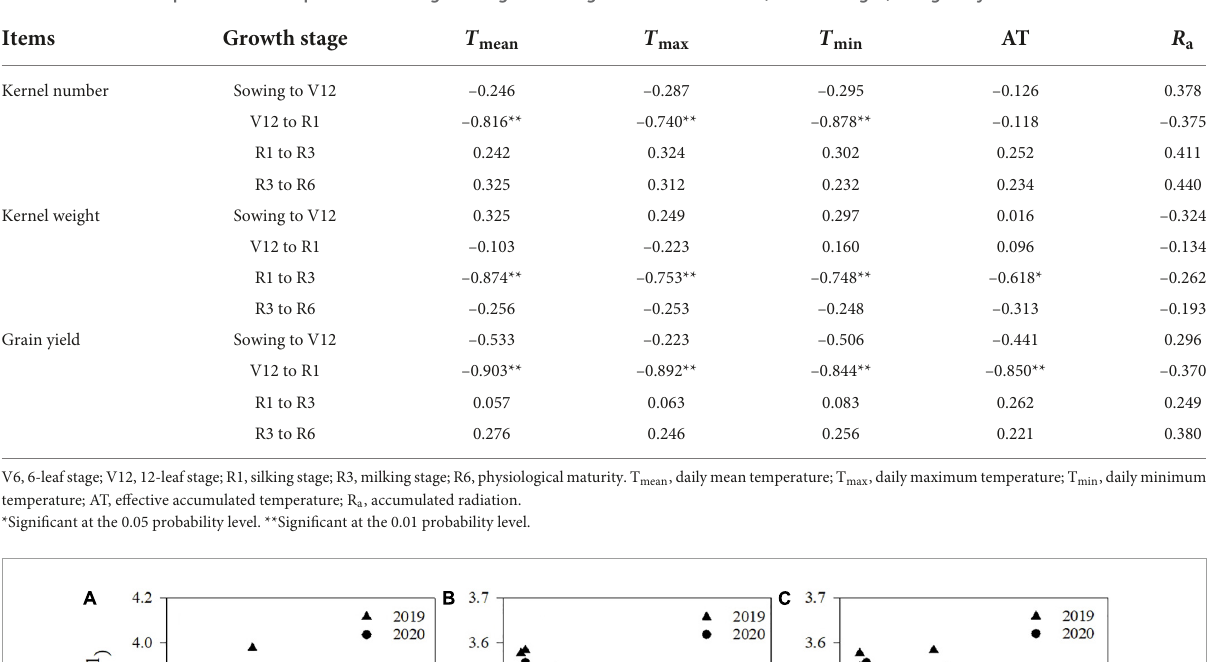
lower temperatures for SD1 from V12 to R1 stages, while for SD3 from R1 to R3 stages compared to SD2, promoted maize leaf to maintain higher antioxidant capacity (e.g., lower MDA and higher activities of SOD, POD, and CAT) and